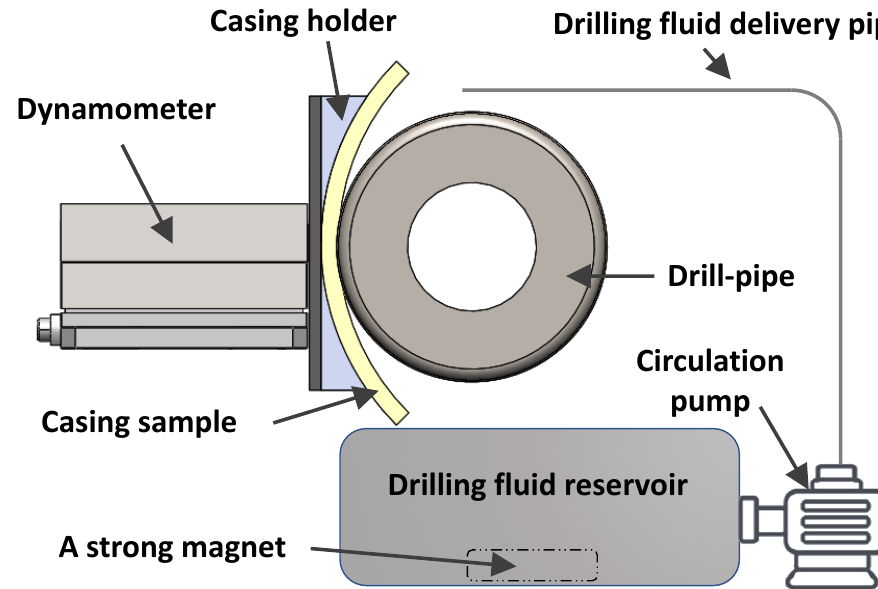
Figure 3. Two-dimensional illustration of the casing wear testing system.